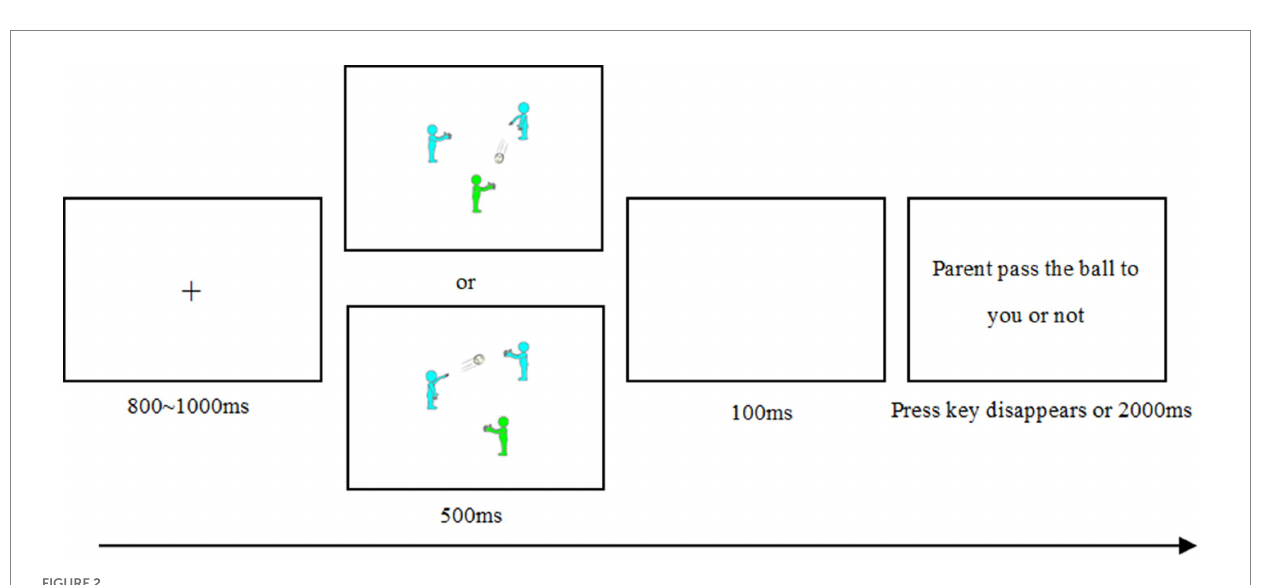
FIGURE 2 Schematic diagram of the experimental process of the passing ball